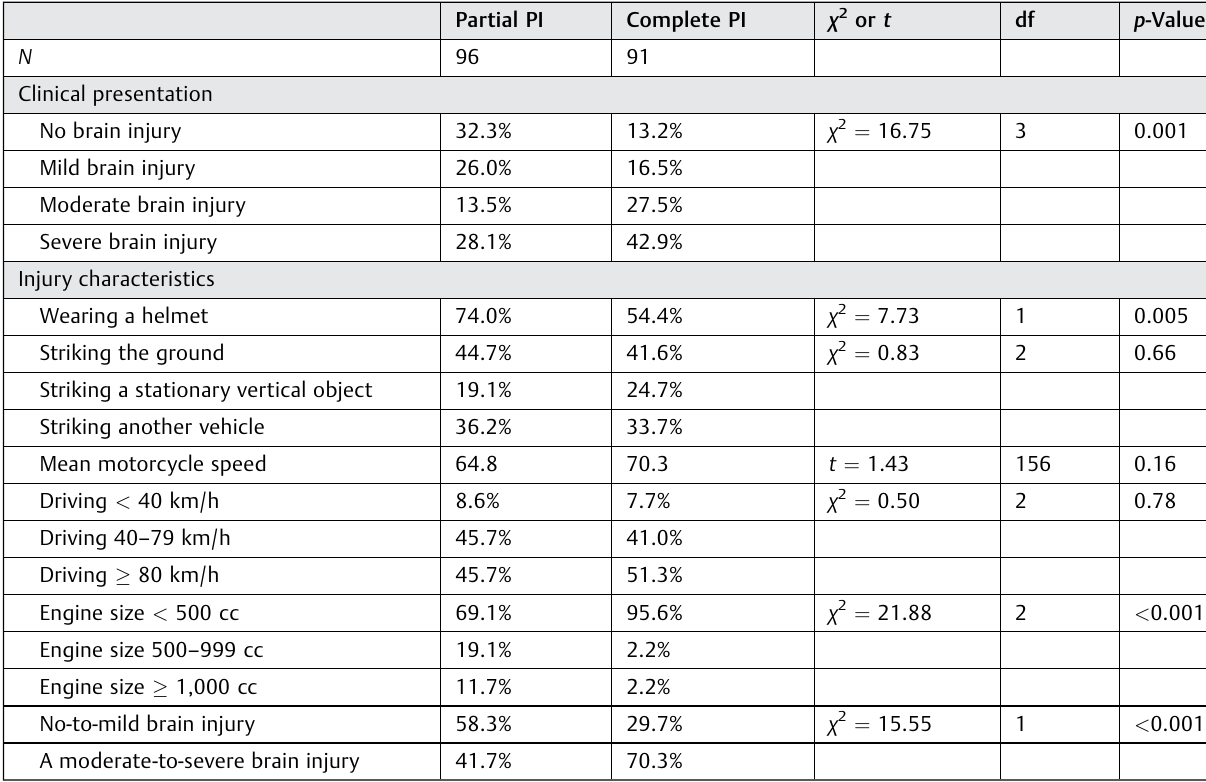
Table 4 Clinical presentation and injury characteristics in patients with an incomplete versus complete PI